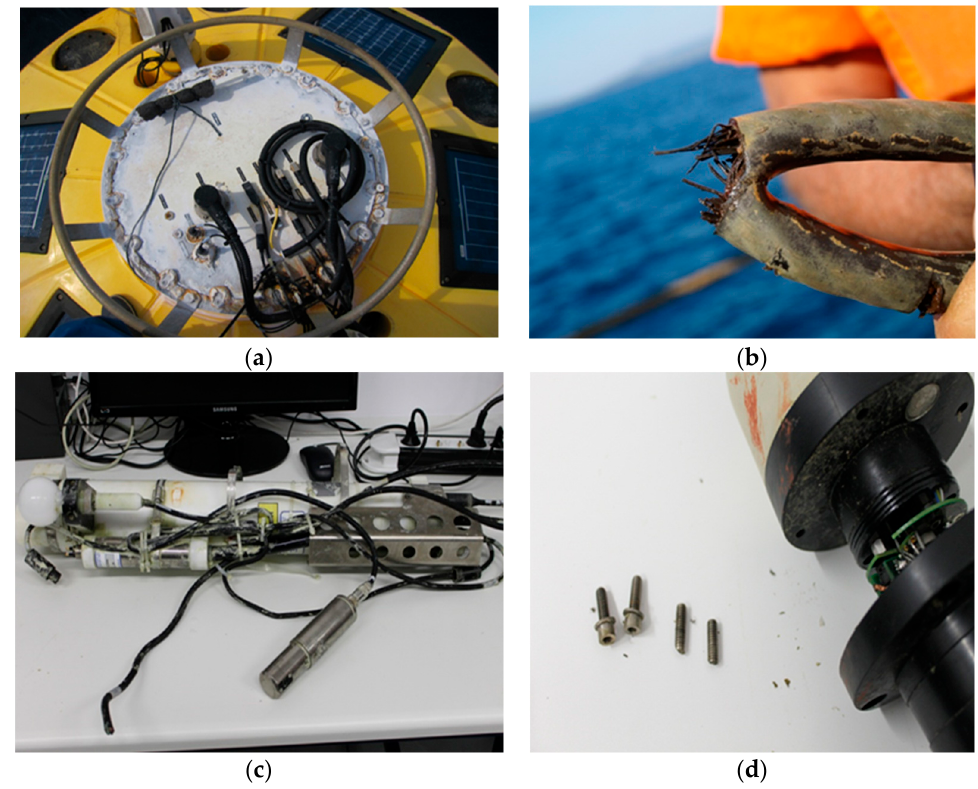
Figure 10. In panel ( a ), the E1M3A buoy displays severe damage caused by a failed powerline, the buoy electronics and power container were destroyed by galvanic corrosion. ( b ) Inductive cable failure resulting in the loss of underwater telemetry. ( c ) A CTD recovered after 12 months of operation with external sensor cabling failures. ( d ) Failure of the screws in the head of an ADCP attached in the surface buoy, the result was the destruction of the sensor.